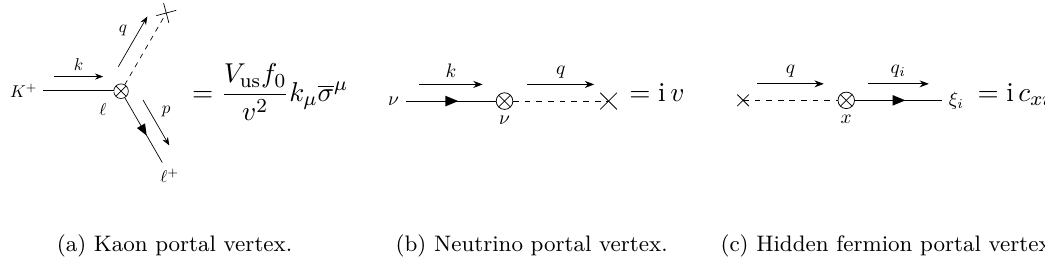
Figure 2. Feynman rules for portal vertices that appear in the example computation of inclusive K + → ‘ + decay rates. The first vertex figure 2(a) determines the size of the reduced matrix element M ‘ , while the second vertex figure 2(b) determines the size of M ν . Both contribute at the same order because M ν is also suppressed by the smallness of the required additional Fermi-theory vertex associated with K + → ‘ + ν decays. The third vertex figure 2(c) determines the size of the hidden currents J ‘ and J ν , and is used in section